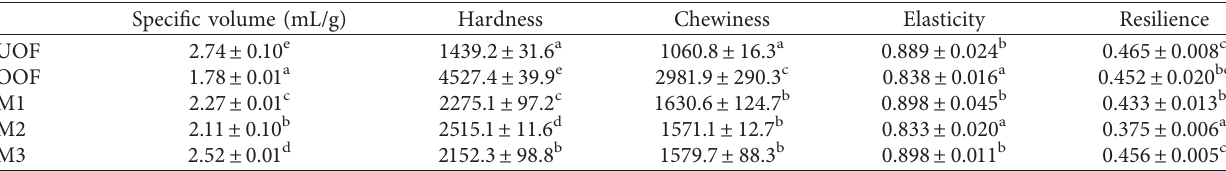
Table 3: The specific volumes and texture attributes of steamed bread made from wheat flour added with different ratios of overozonized wheat flour † .